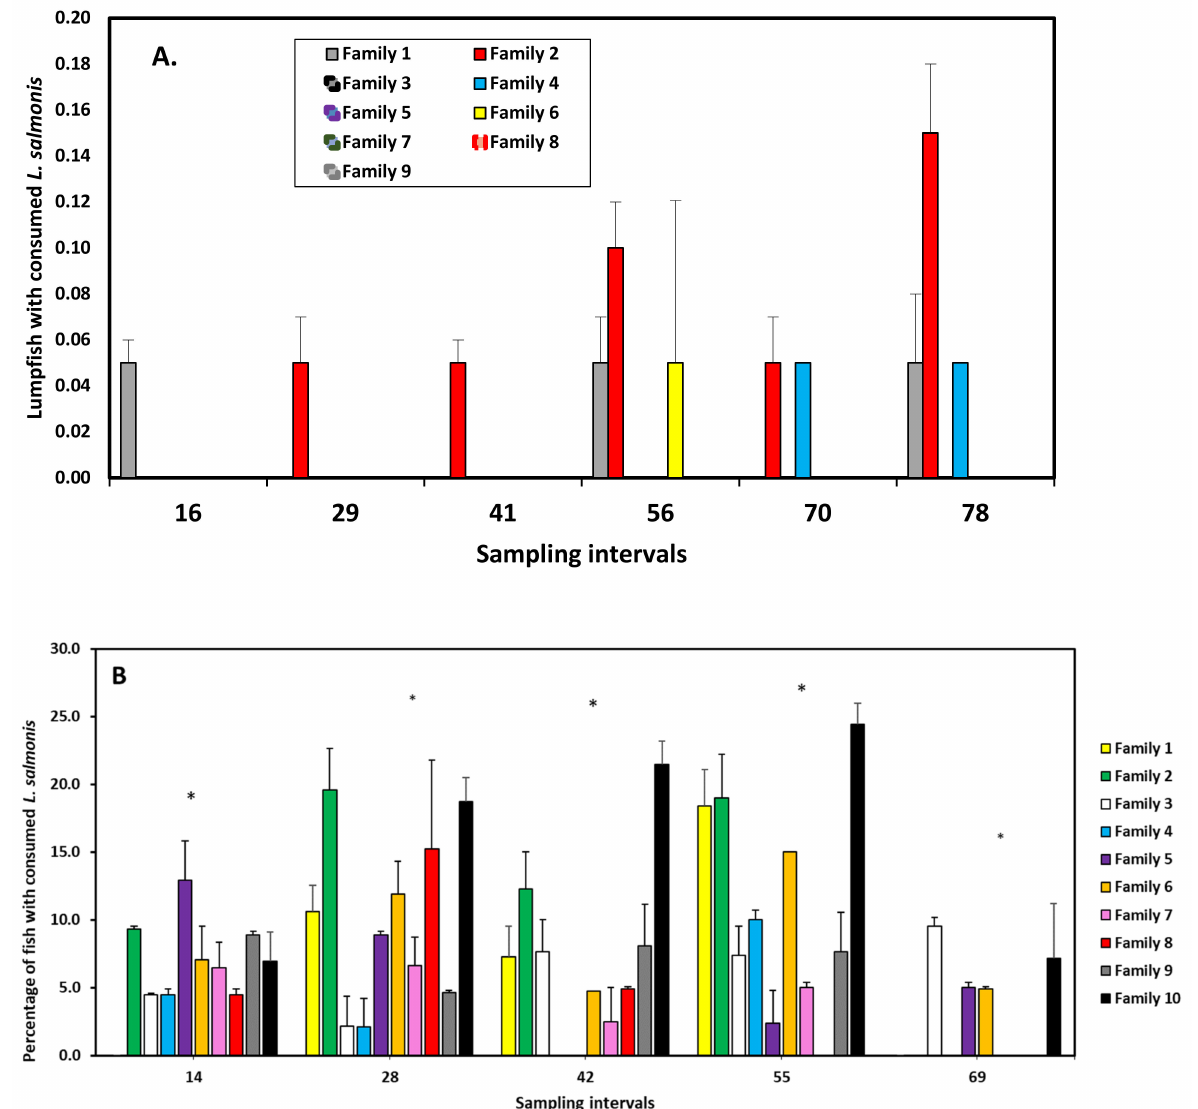
Figure 3. ( A , B ). Mean percentage values L. salmonis found in the stomach of different lumpfish fami- lies reared together with Atlantic salmon in small sea cages. Values are presented as means ± S.E. The figure is modified from ([24], ( A )) and ([31], ( B )). * indicates significant differences between